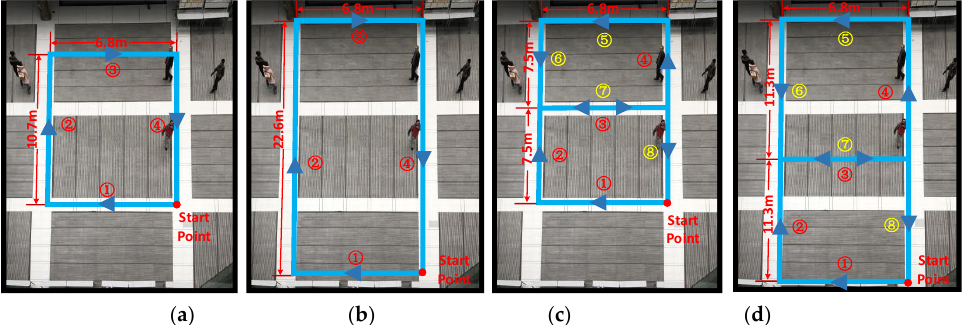
Figure 10. Pedestrian-positioning test route: ( a ) Route A; ( b ) Route B; ( a ) Route C; ( b ) Route D. Table 2. Pedestrian-positioning test-related parameters.